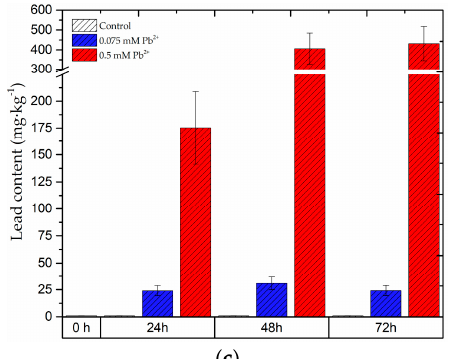
Figure 10. Lead contents in roots ( a ) and leaves ( b ) of pea seedlings and in bodies of pea aphids ( c ). The data were obtained in three independent experiments and statistically analysed using ANOVA ( p -values at α = 0.05). Hypotheses on the equality of means were verified by the two-sample t -test. To account for multiple testing, we used the Bonferroni correction (statistically significant differences are shown in Table S1, S2).